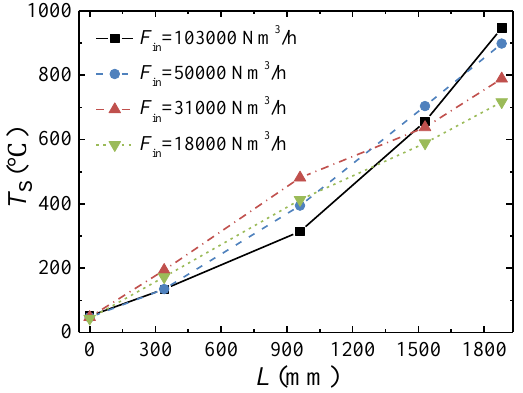
Figure 7. Solid temperature ( T s ) profile in bed 1 along the length ( L ) of the TFRR at the end of the heat-absorbing state for automatic thermal maintenance with different inlet flow rates ( F in ).